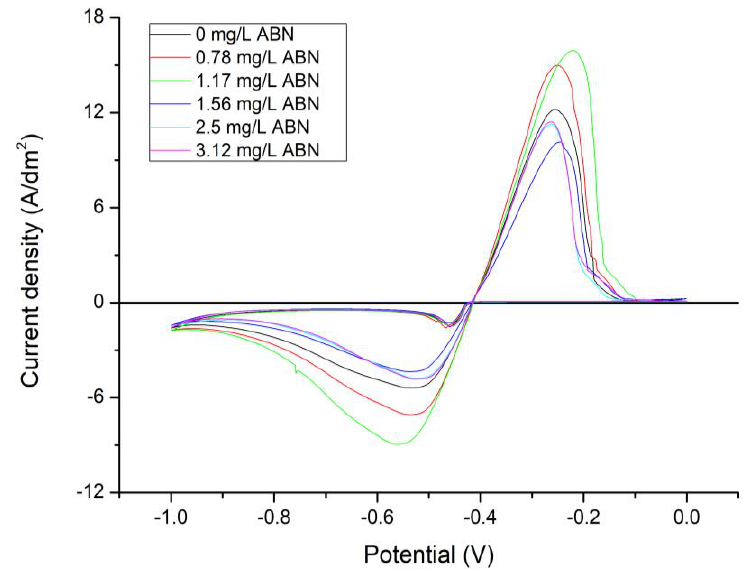
Figure 8. Cyclic voltammograms in MSA electrolyte for different ABN concentrations.